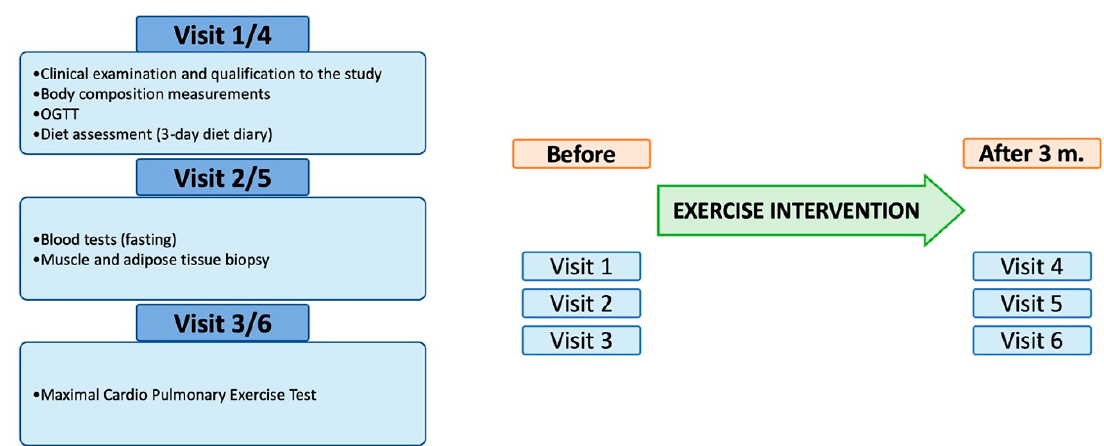
Figure 1. Schematic diagram of the project design and description of each patients’ visit to the study center. OGTT—oral glucose tolerance test.